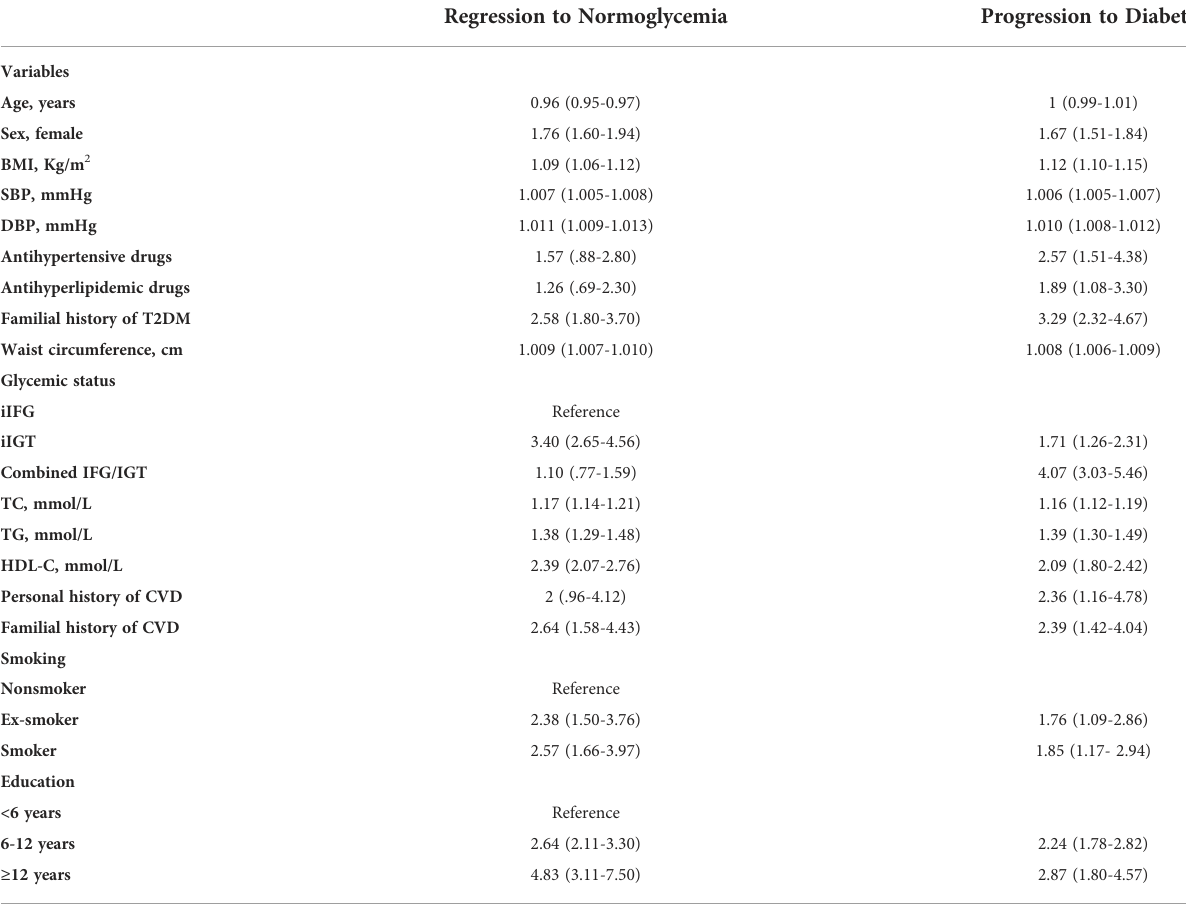
TABLE 3 Prognostic factors associated with regression and progression in prediabetes over a 10-year follow ‐ up in a uni-variable analysis a . Regression to